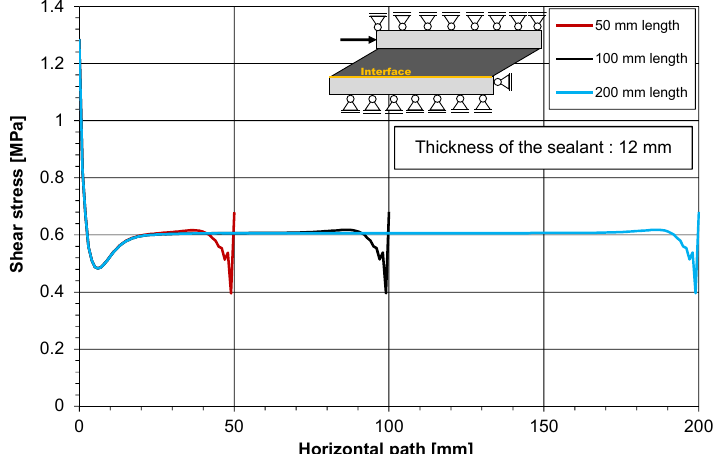
Fig. 23 Shear stress distribution in the silicone sealant at the interface to the adherend for different lengths and the same element size as well as the same applied displacement. A constant thickness of 12 mm is considered for the sealant. The same procedure was carried out for the specimen with a length of 100 mm and the three different thicknesses (6 mm, 12 mm and 24 mm). Figure 24 shows the stress distribution in the silicone sealant at the interface between silicone and steel for the three considered thicknesses. Again, the finite element model detailed in section 3.2 was used and a constant engineering shear strain of 1 (i.e. a displacement of 6 mm for the specimen with a thickness of 6 mm for example) was applied for the considered specimen. Again, the same element size of 1 mm was used for the three models for a simplified comparison of the stress levels using identical meshes. In figure 24, it can be observed that the shear stresses at the edge area increase with the thickness. So, for the same applied shear strain, the 24 mm specimen exhibits the highest peak value. Figure 25 shows the stress distribution in the centreline of the adhesive for the same model as described before. At the centreline, the shear stress distribution is almost constant, with the highest value obtained for the specimen with a thickness of 6 mm.